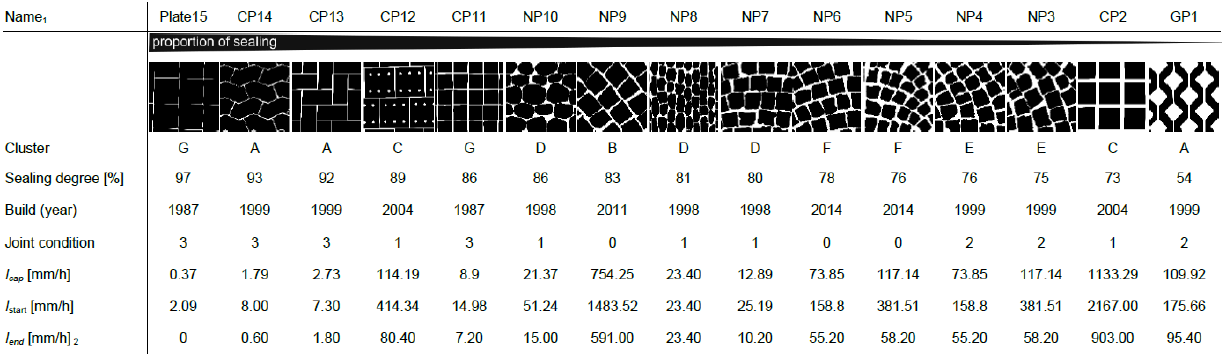
Table 1. Characteristics of the PPs considered within the case study. For further information, see Schaffitel et al. (2020).